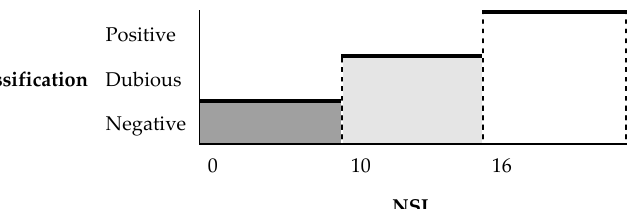
Figure 7. A simple rule to transform a metric such as the number of straight lines (NSL) into an image classification as static diagram classification as static diagram.